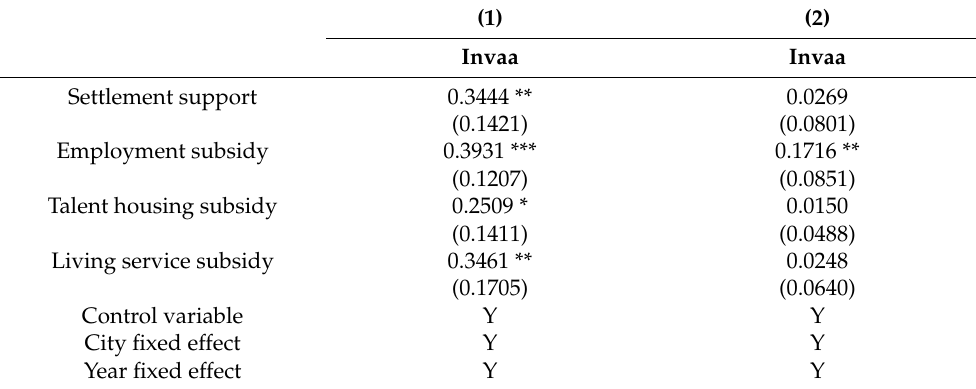
Table 6. Regression results of influence mechanism of talent policy subsidy